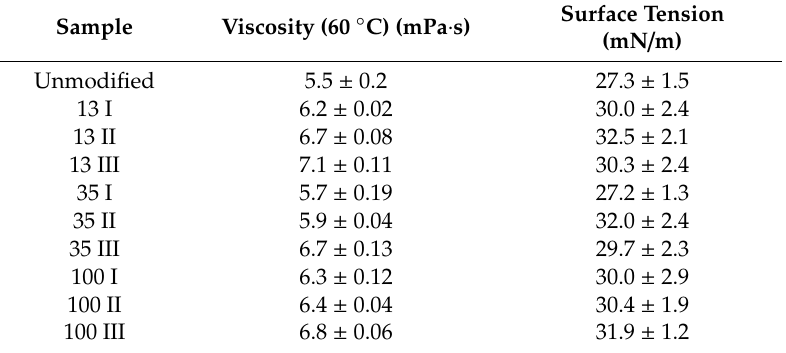
tension of the inks after filtration.